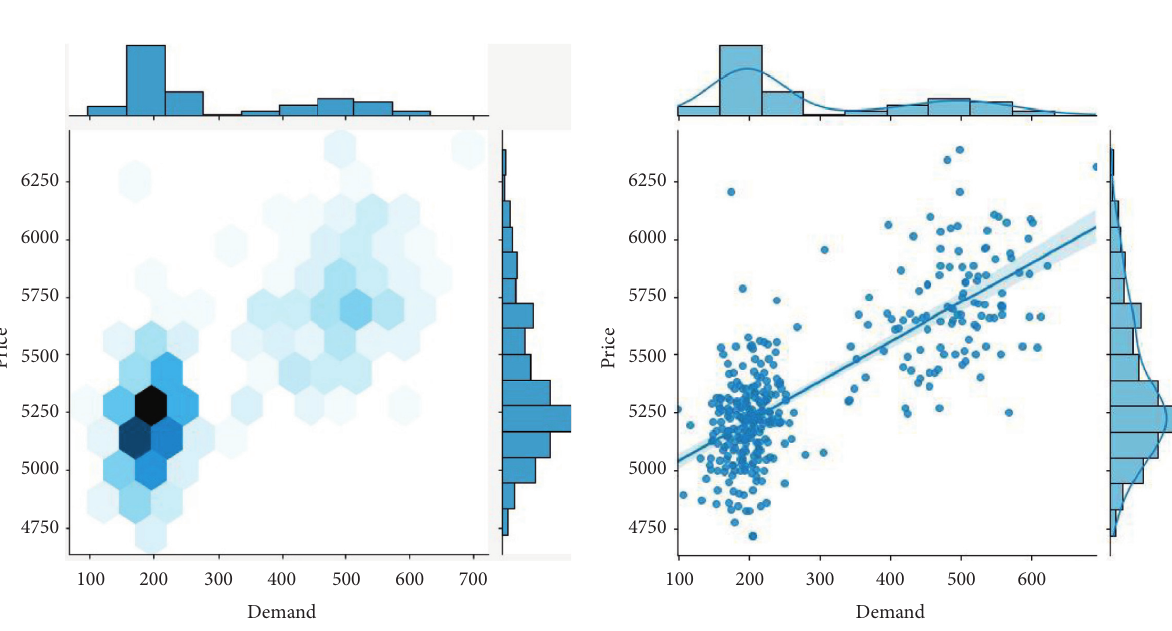
Figure 13: Price plot with